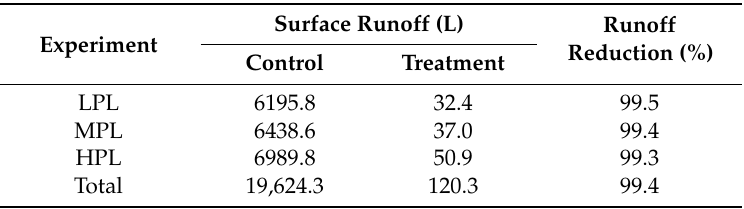
Table 1. Summary of Surface Runoff Measurement.